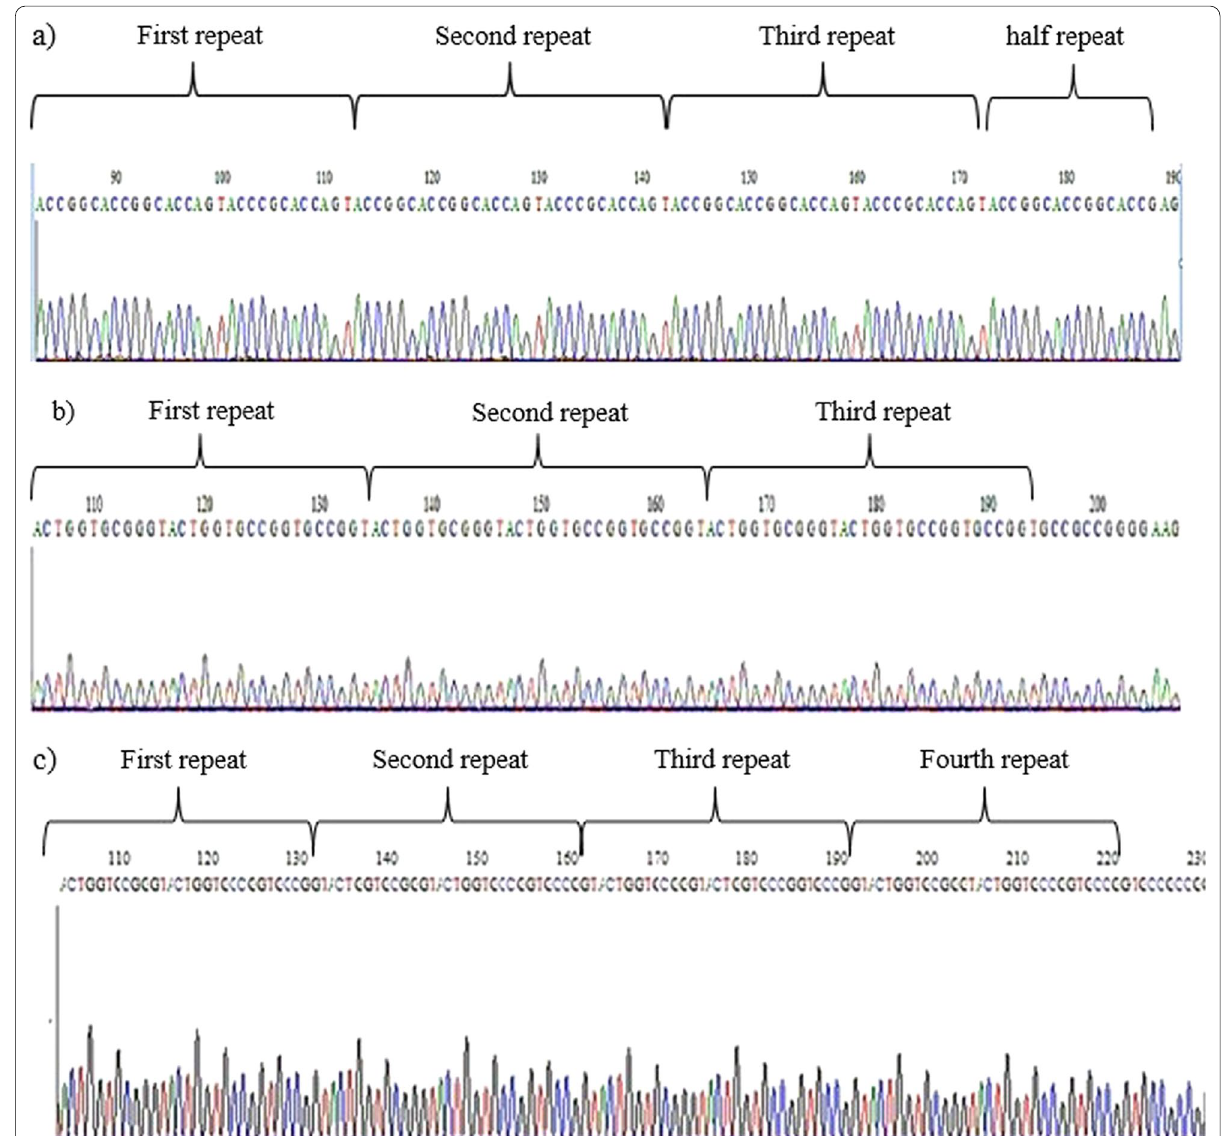
Fig. 2 Sequencing examination of MAOA-uVNTR polymorphism PCR products. a 3.5 repeat genotype sequenced by forward primer. A 30 bp "ACC GGC ACC GGC ACC AGT ACC CGC ACC AGT " sequence shows a complete repeat and "ACC GGC ACC GGC ACC" sequence depicts half of repeat. b 3 repeat